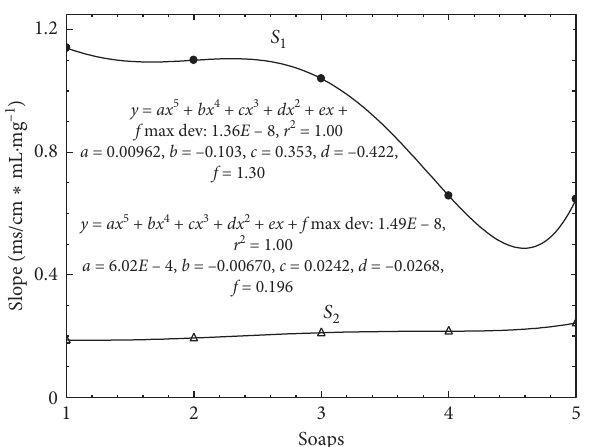
does not facilitate the micellization [25].